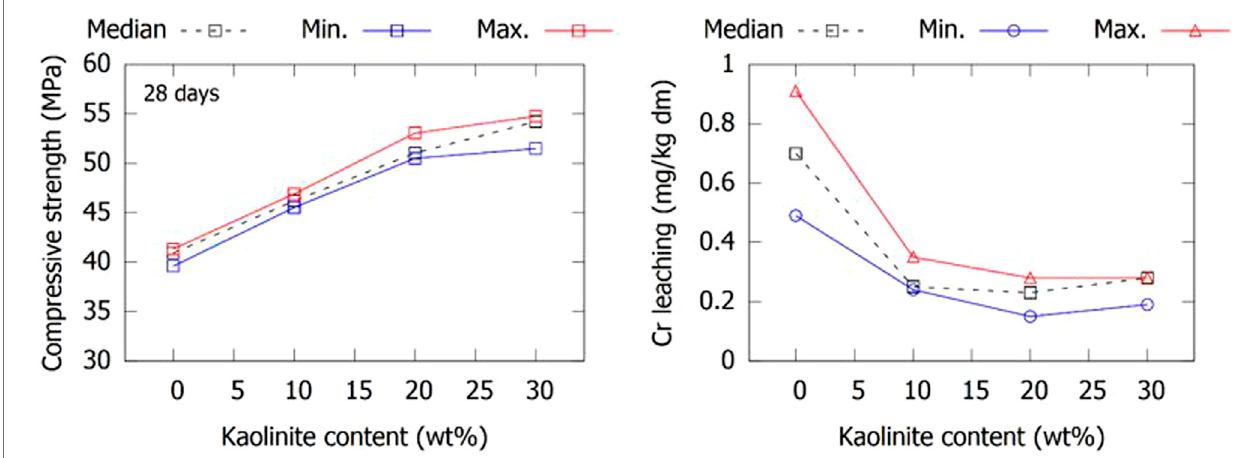
FIGURE 12 | The variation with kaolinite addition to BR before calcination of the compressive strength and chromium leaching of mortars after 28 days.